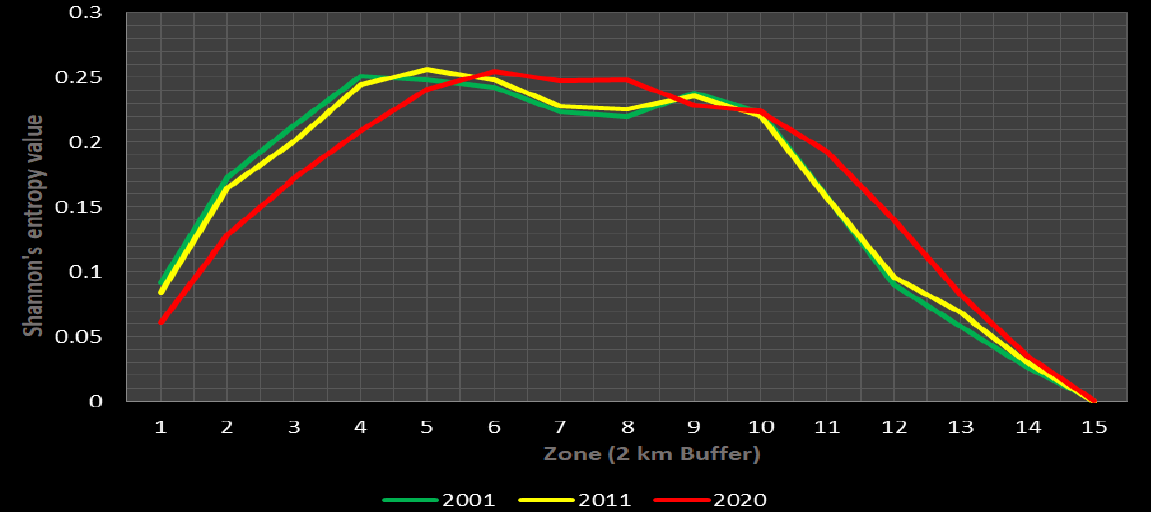
Figure 5. Zone-wise value of Shannon's entropy in Delhi for the years 2001, 2010 and